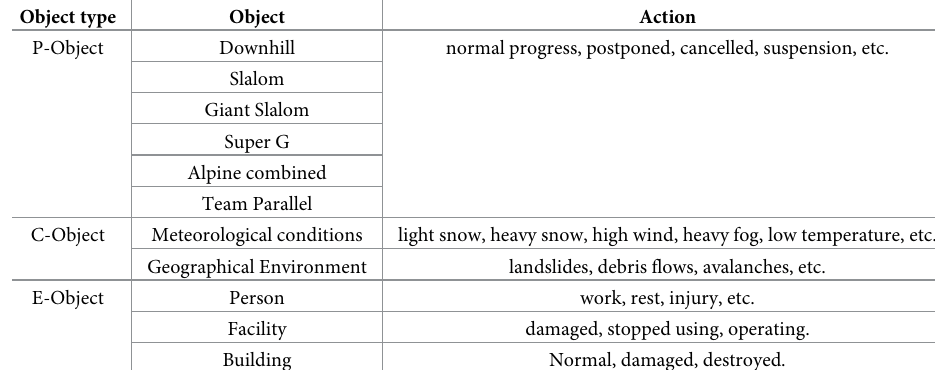
Table 2. Some actions of